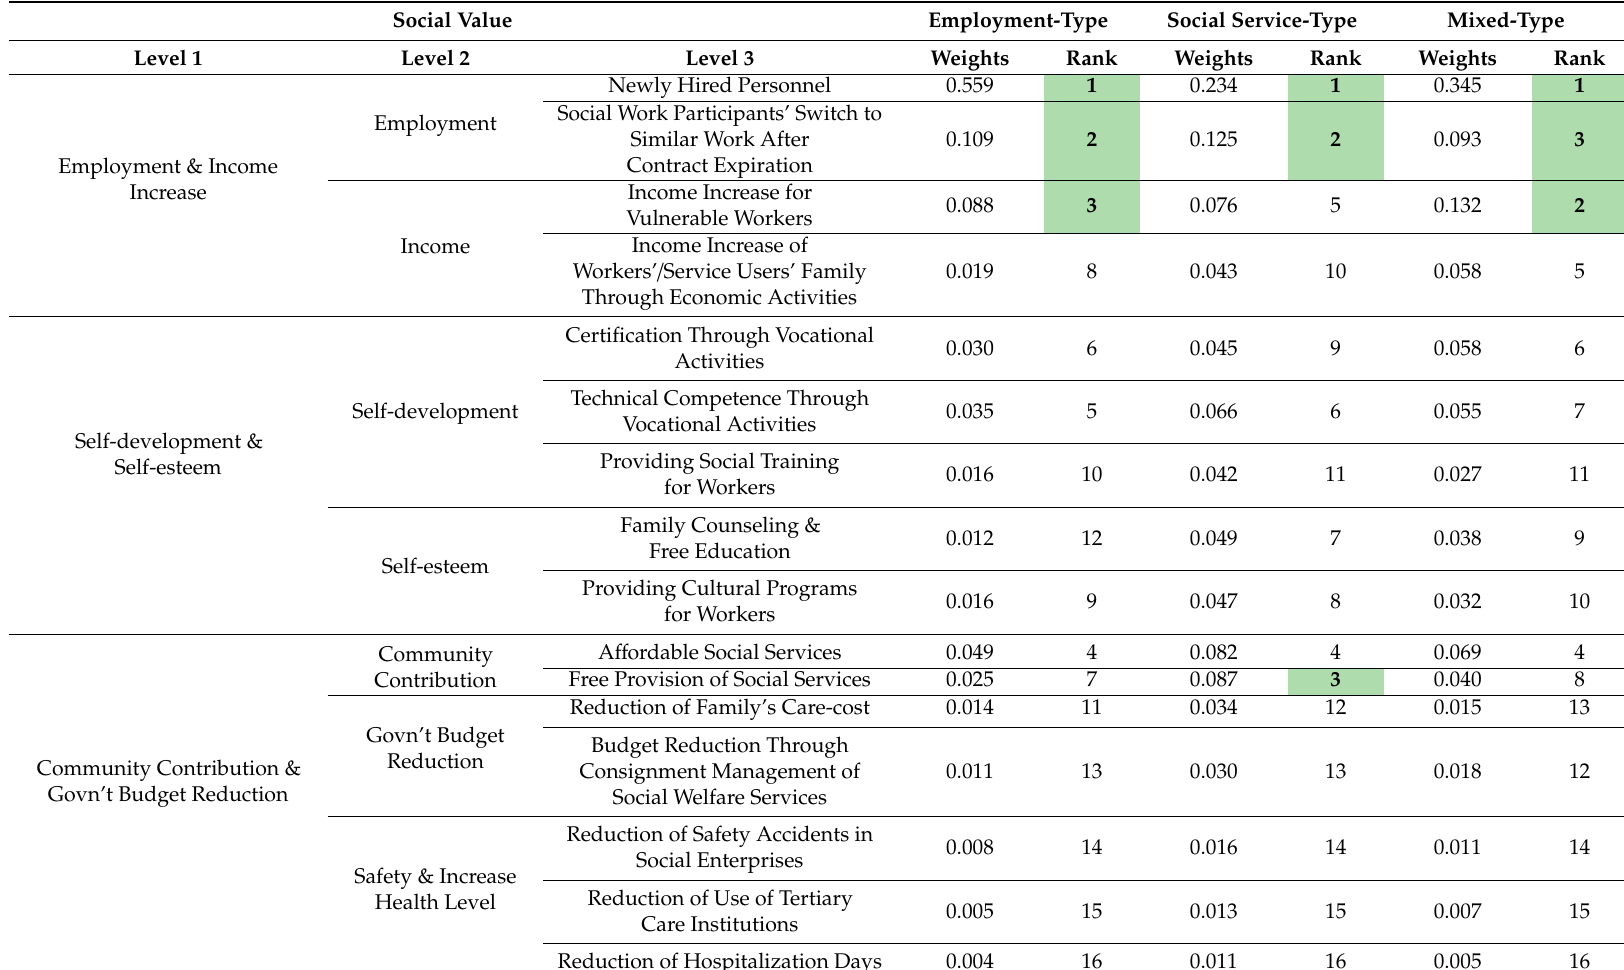
Table 4. Items and Weights by Type of Social